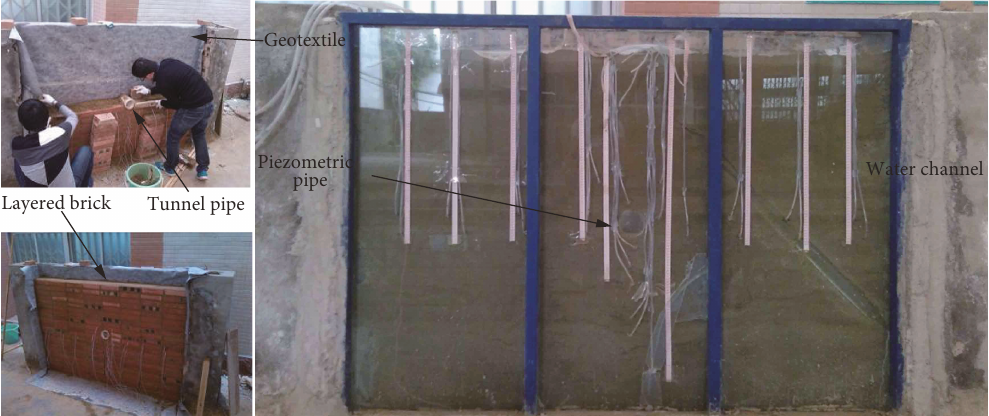
Figure 5: Physical model and its local details.